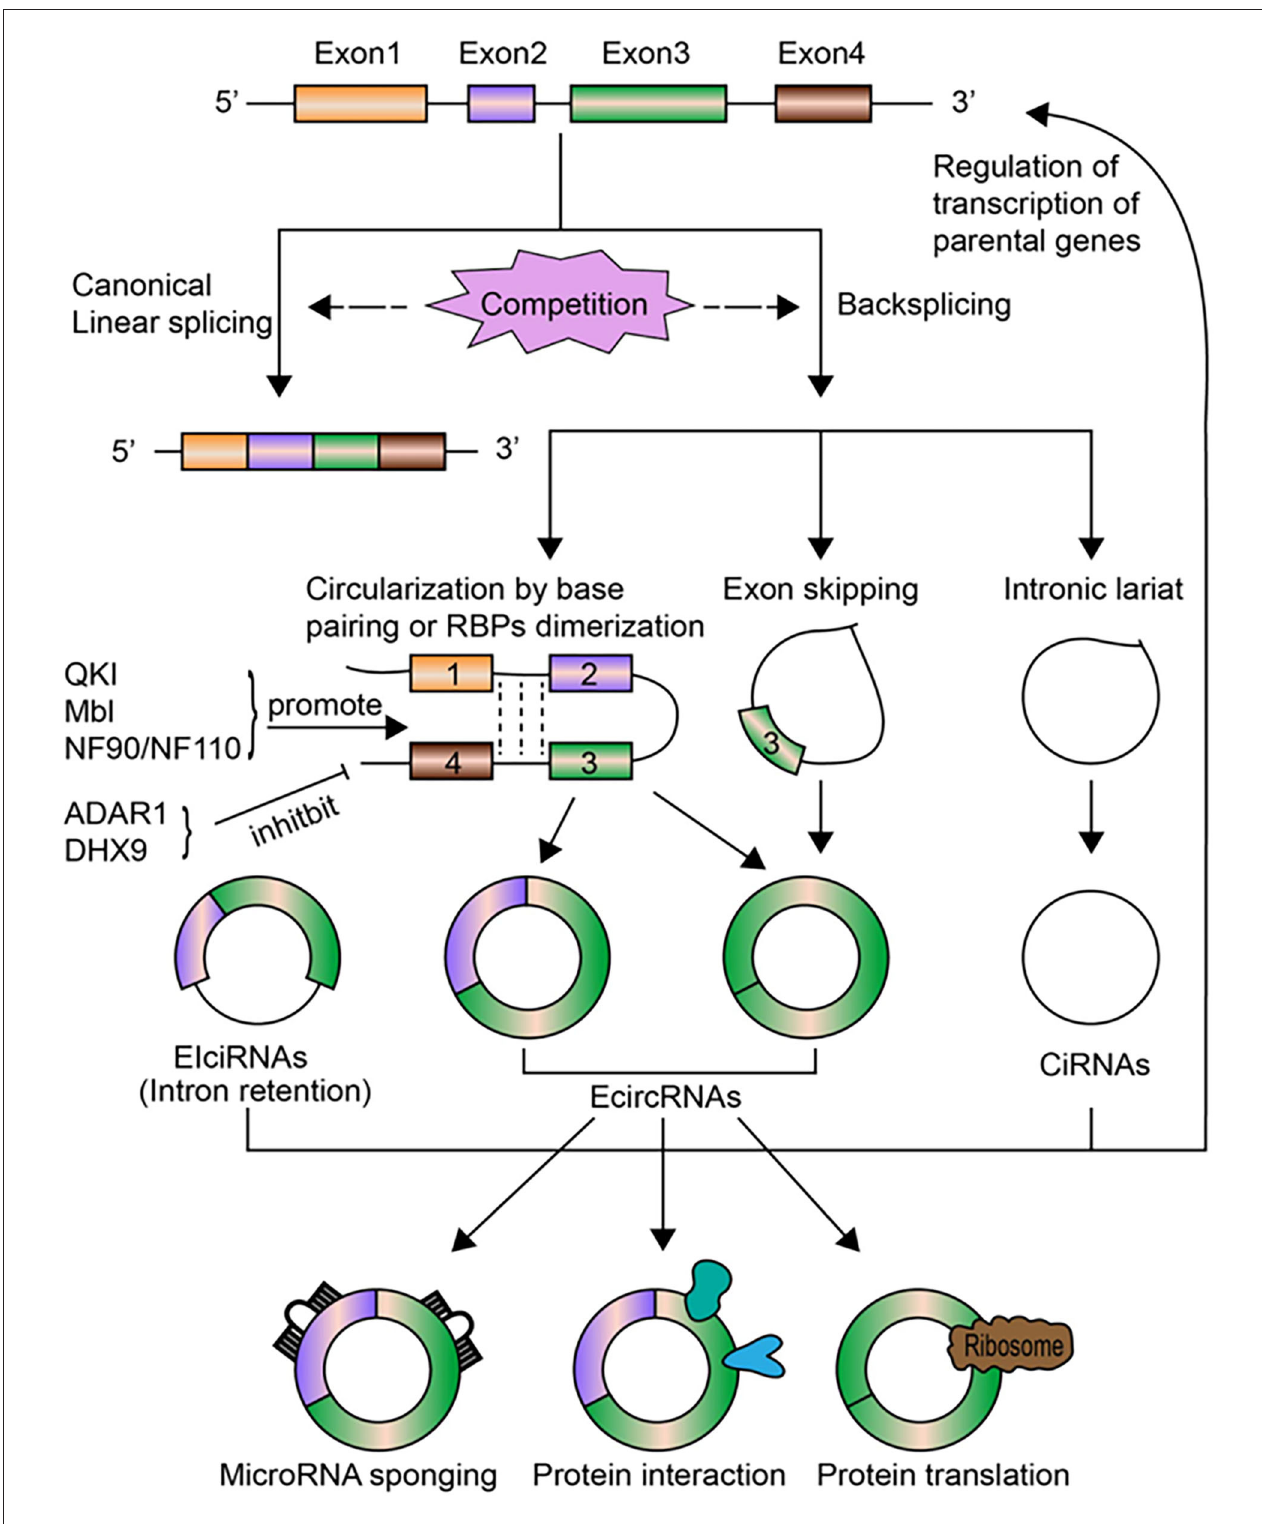
FIGURE 1 | The biogenesis, regulation, and functions of circRNAs. CircRNAs are transcribed from pre-mRNAs through the non-canonical back-splicing event. The back-splicing process involves different mechanisms, including circularization by base paring of intronic sequences or RBPs dimerization, exon skipping, and